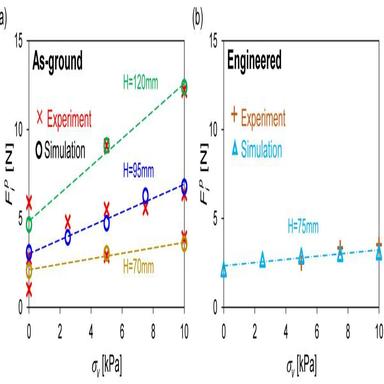
Comparison of peak force on the intruder Fi p with different pre-consolidation pressures σv for the simulations and the physical measurements for the as-ground sample (a) and the engineered sample (b). H represents the initial sample height before consolidation.